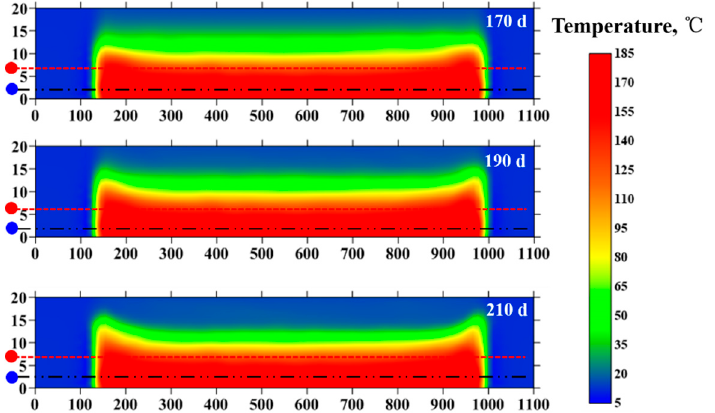
Figure 17. Effect of the injection time on the steam chamber. Figure 17. E ff ect of the injection time on the steam